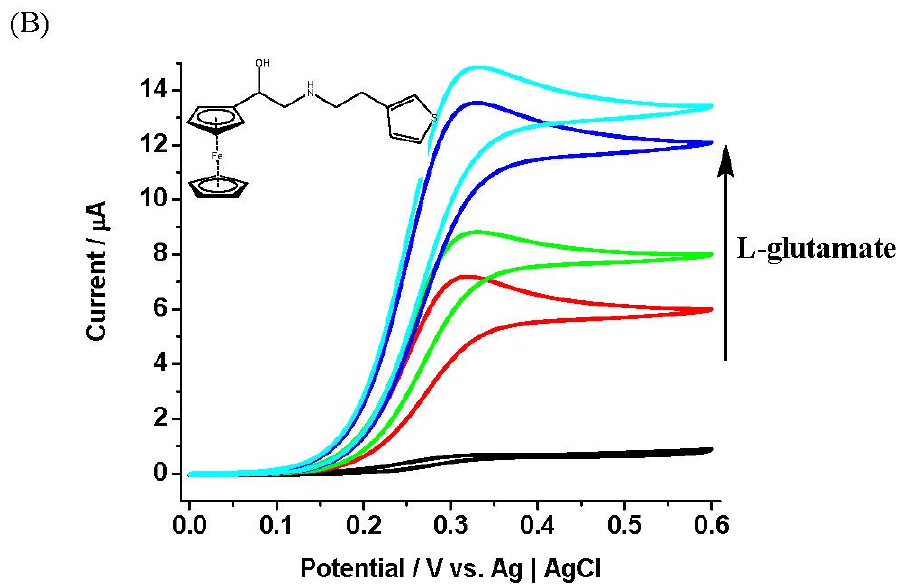
Figure 1. ( A ) Cyclic voltammetry responses of (3-(1 H -pyrrol-1-yl)propanamido) ferrocene ( 2 ) (1 mM) towards successive additions of L-glutamate (0–40 mM) at a GlutOx electrode. Solution: PBS pH 7.2 (10 mM)-KCl (10 mM) (black curve). Potential sweep, 0–+0.6 V vs. Ag|AgCl, scan rate 10 mV s − 1 . ( B ) Cyclic voltammetry responses of (1-hydroxy-2-(2-(thiophen-3-yl)ethyl amino)ethyl)ferrocene ( 6 ) (1 mM) towards successive additions of L-glutamate (0–20 mM) at a GlutOx electrode. Solution: PBS pH 7.2 (10 mM)-KCl (10 mM) (black curve). Potential sweep, 0–+0.6 V vs. Ag|AgCl, scan rate 10 mV s − 1 .